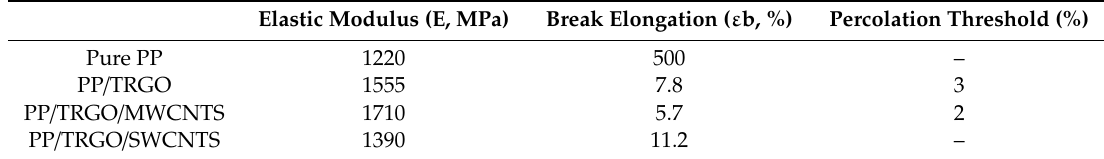
Table 2. Comparison of mechanical